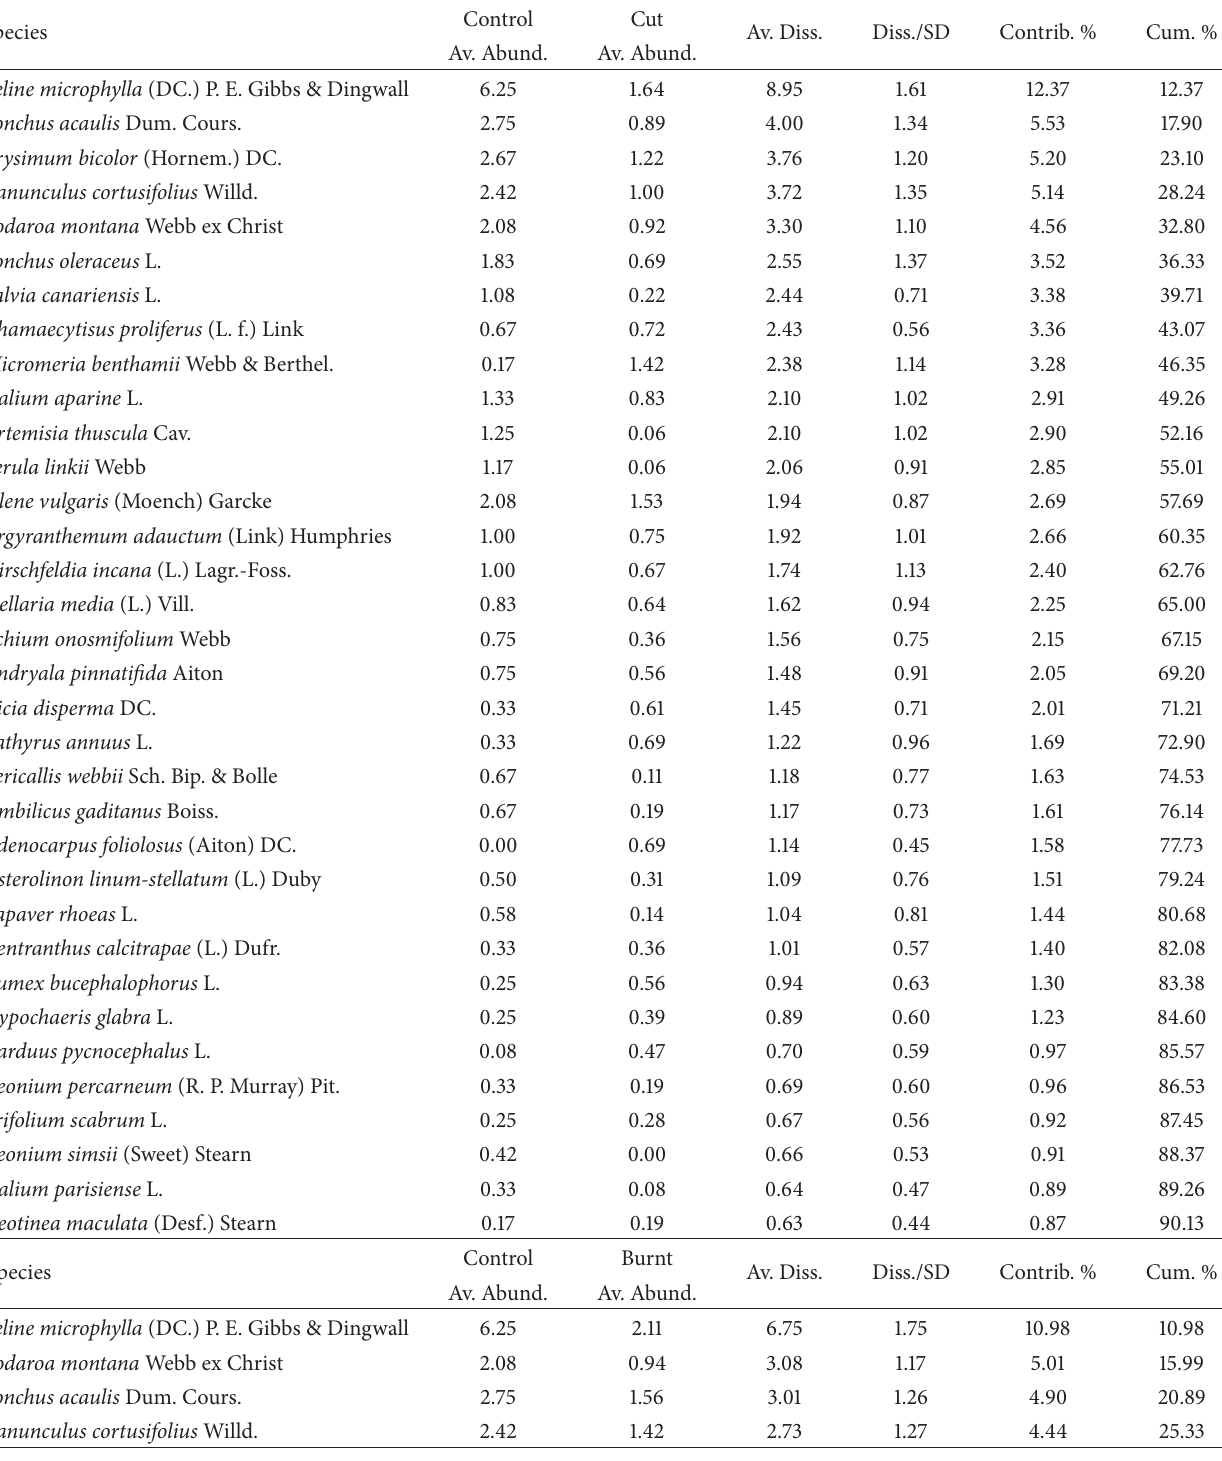
Table 5: Cutting and burning effects on species composition in Pinus canariensis forest stand (Gran Canaria, Canary Islands). Results of the SIMPER procedure conducted to discriminate those taxa that primarily contribute to average dissimilarity between treatments. The species which contribute most to the differences between treatments, using a cut-off cumulative percentage of 90%, are listed. Average dissimilarity: control versus cut = 72.35, control versus burnt = 61.52, and cut versus burnt = 72.06. Av. Abund.: average abundance of taxa based on a